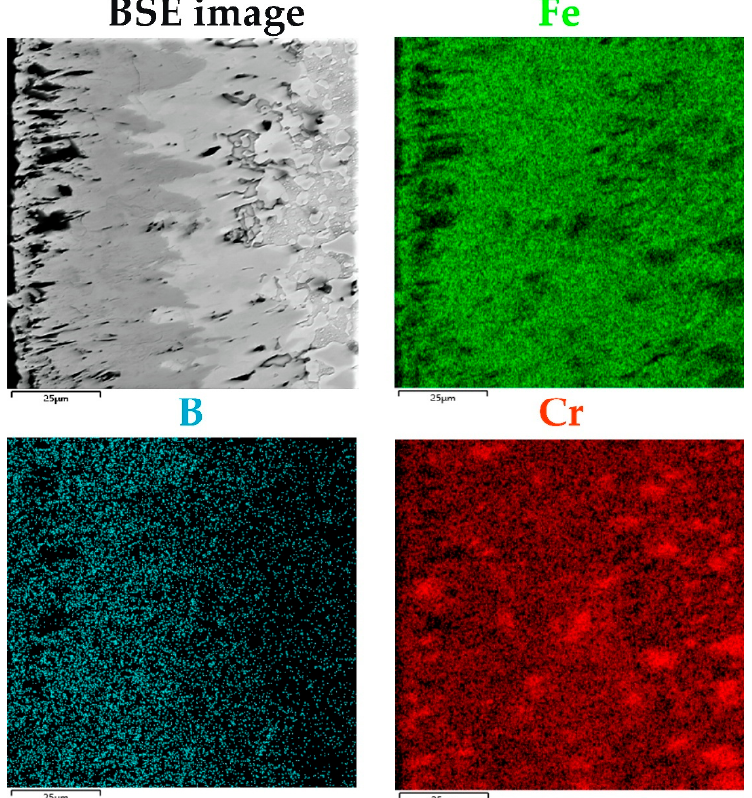
Figure 10. BSE images and results of EDS mapping performed for X165CrV12 tool steel after powder-pack boriding at the temperature of 1223 K for 9 h.